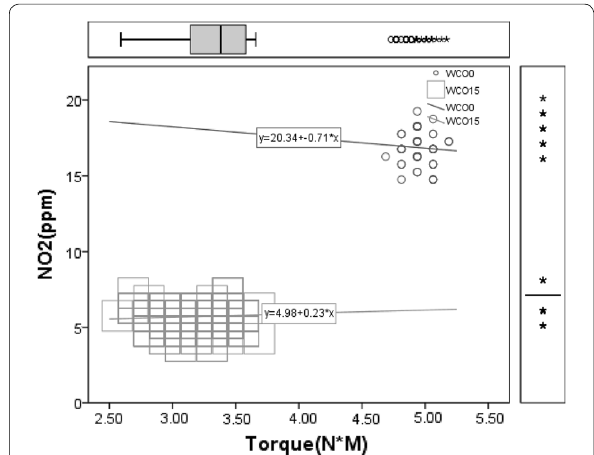
Fig. 14 Scatter plot diagrams for the exhaust characteristics versus torque output [NO 2 emission (Unit: ppm)]